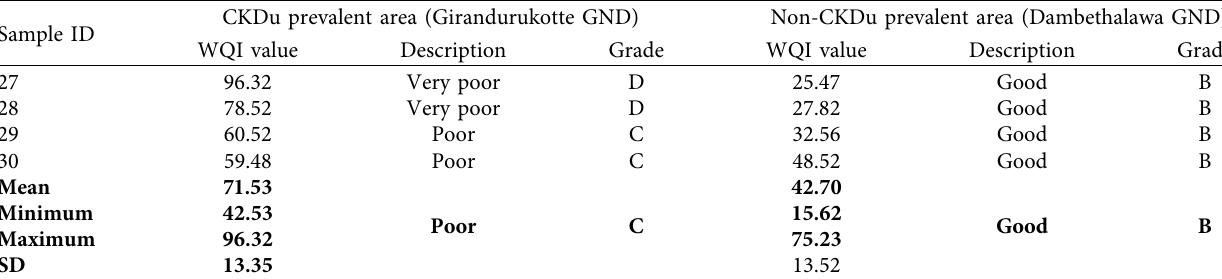
T able 5: Continued.